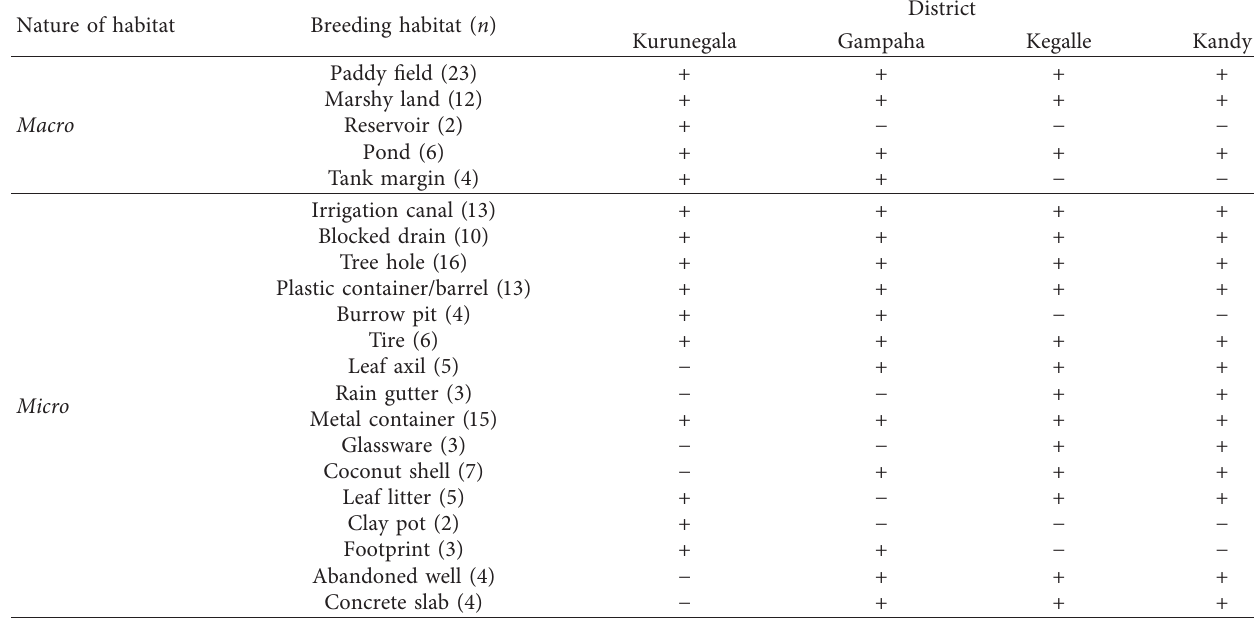
Table 3: List of breeding habitats encountered in Kurunegala, Gampaha, Kegalle, and Kandy districts, Sri Lanka. Nature of habitat Breeding habitat ( n